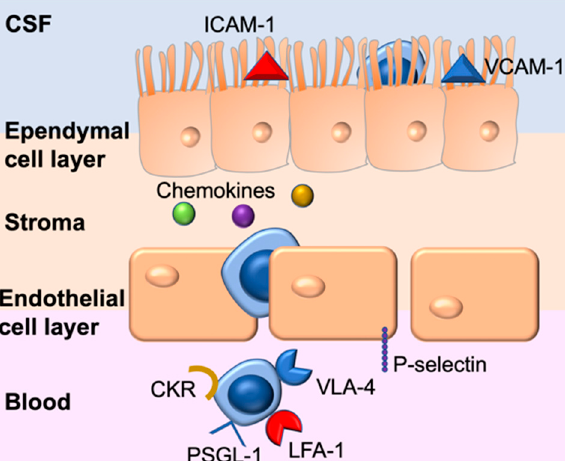
Figure 1. Lymphocyte migration across the BCSFB. Lymphocytes expressing PSGL-1 interact with P-selectin constitutively expressed on the endothelial cell layer of the CP. In the stroma, lymphocytes expressing chemokine receptors (CKR) matching the chemokines present at the CP are attracted to migrate across the ependymal cell layer. In the CSF of the CP, lymphocytes can either attach via interactions between integrins LFA-1 and VLA-4 with the respective cell adhesion molecules ICAM-1 and VCAM-1, or remain in the CSF.